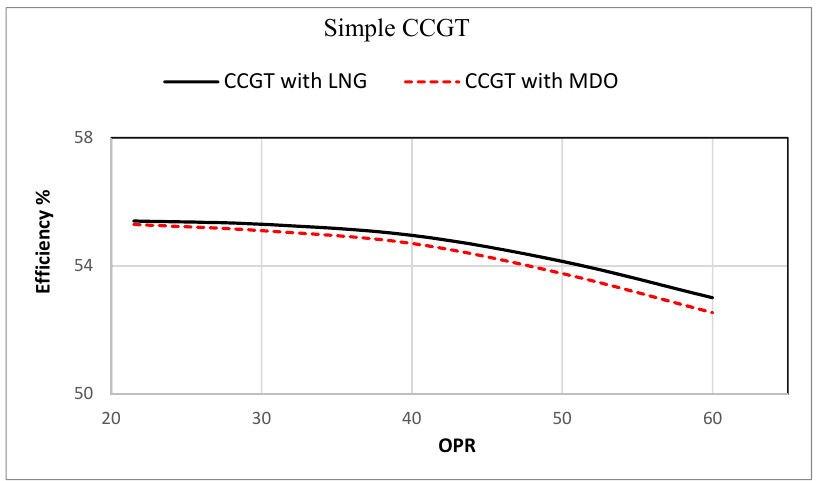
Figure 6. Effects of the compression ratio on the overall thermal efficiency. MDO: marine diesel oil; OPR: overall pressure ratio.